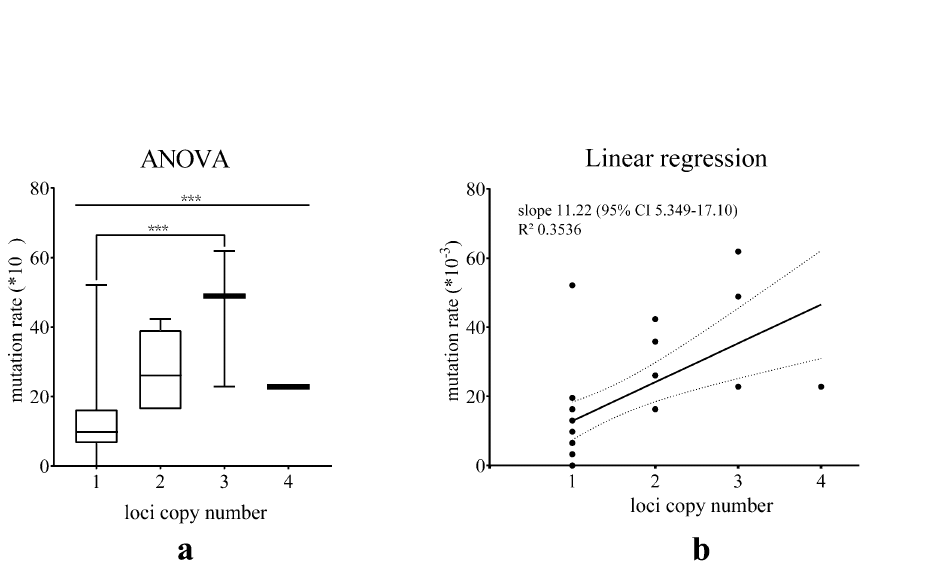
Figure 1. ( a ) One-way ANOVA for mutation rates on loci with different copy numbers; ( b ) Linear regression analysis for mutation rates on loci with different copy numbers (dashed lines represented the 95%